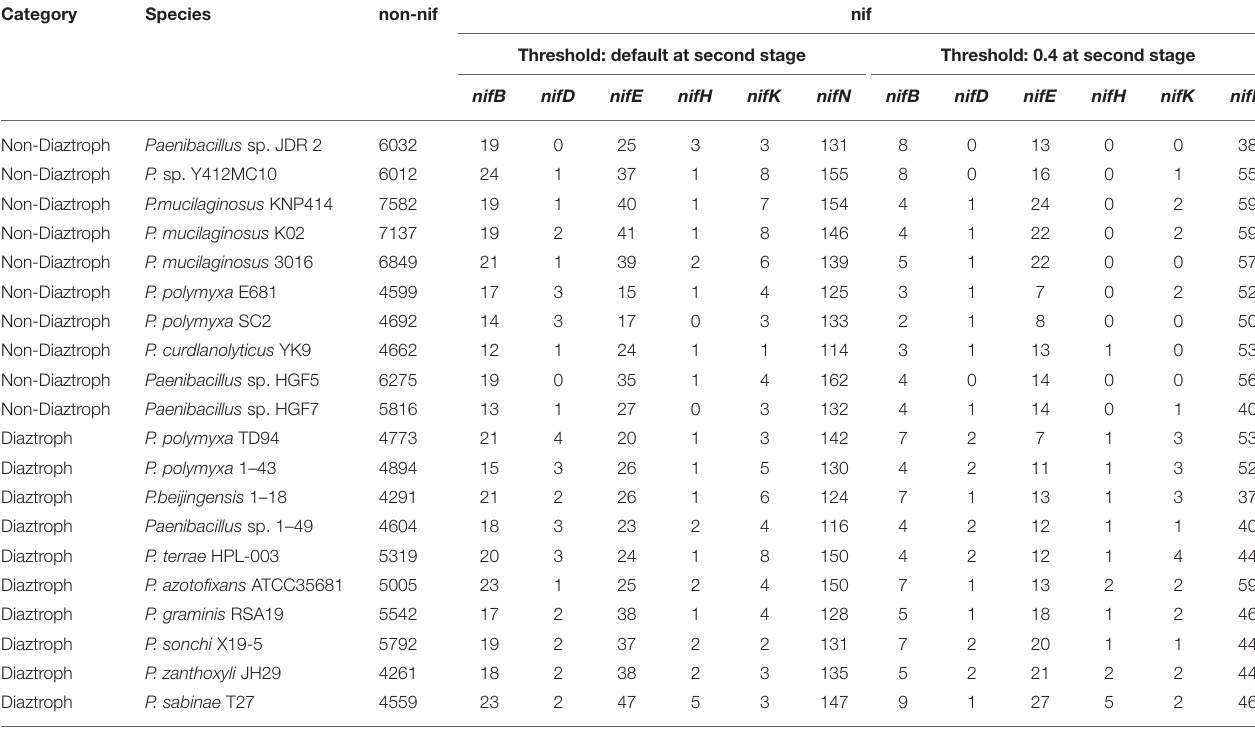
TABLE 4 | Performance of the proposed approach for prediction of nitrogen-fixation (nif) proteins using proteome-wide datasets. Category Species